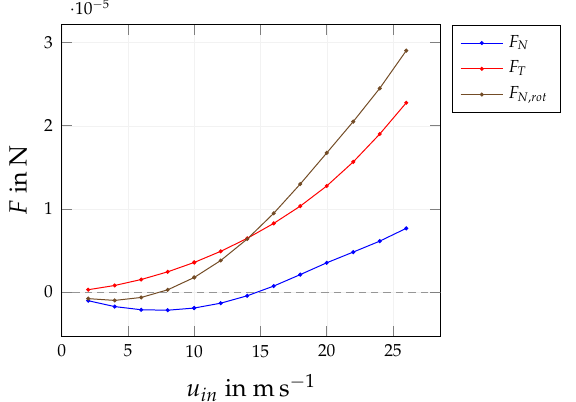
Figure 15. Comparison of standard normal force F N , tangential force F T and rotation-induced normal force F N , rot at convergence with a resolution of N = 96 for different inflow